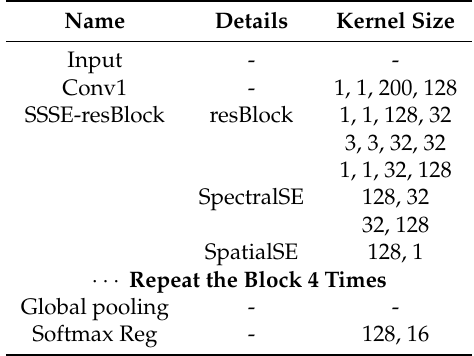
Table 1. Network architecture details of SSSERN for the Indian Pines